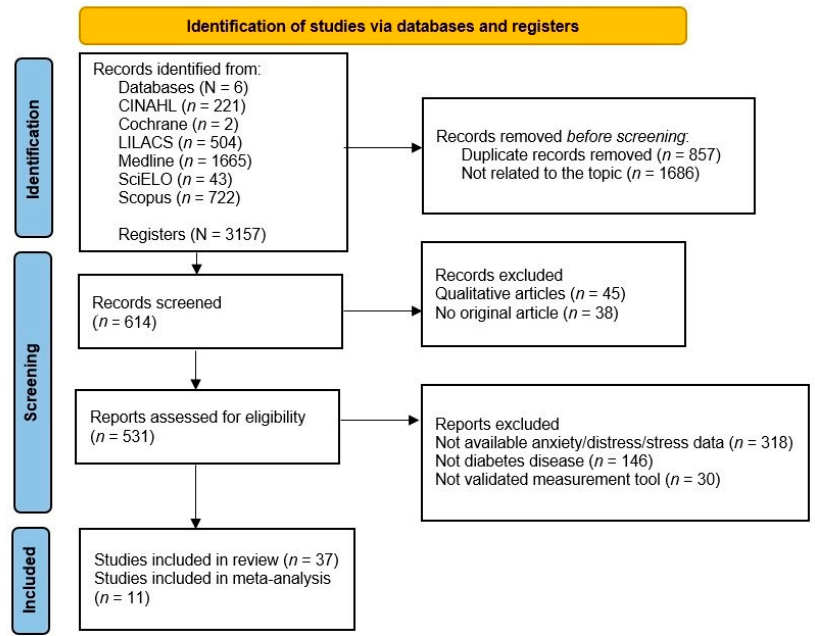
Figure 1. Flow diagram of the selection process.